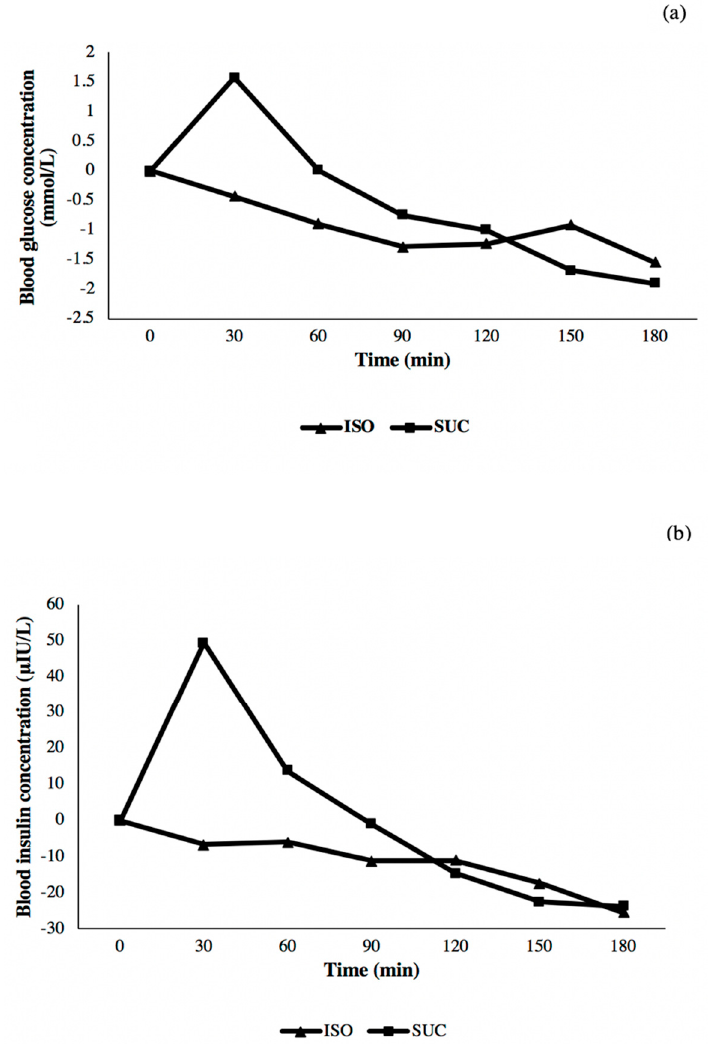
Figure 3. Incremental mean blood glucose ( a ) and insulin responses ( b ) in 12 participants to ISO and SUC beverages.